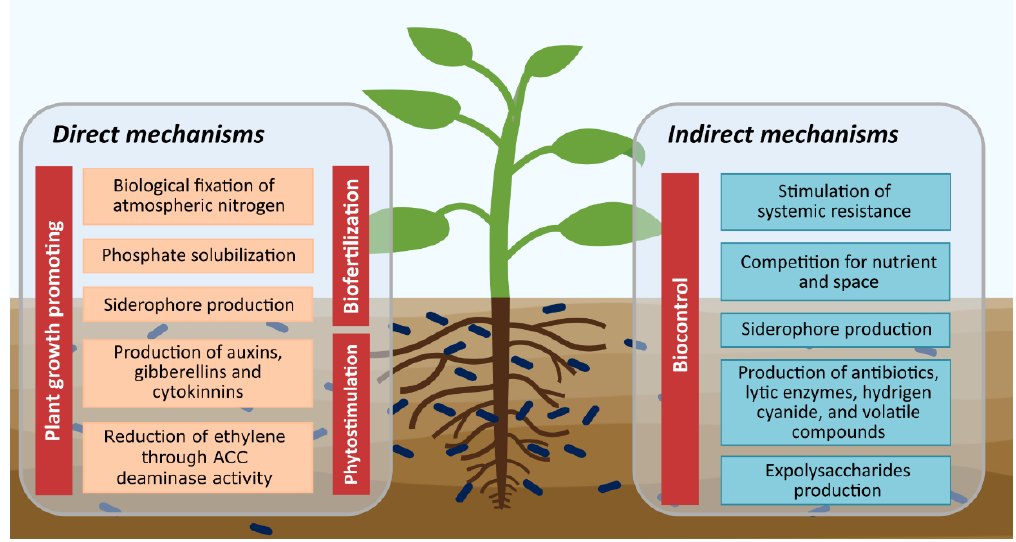
Figure 1. Plant growth-promoting and biocontrol mechanisms by